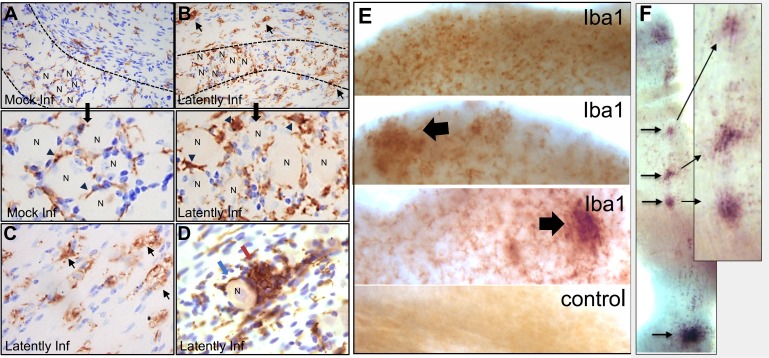
Detection of Iba1+ microglia in HSV infected and mock infected ganglia.Ganglia (A-D) were directly fixed in 4% formaldehyde, embedded, sectioned, and assayed for Iba1 expression as described in Methods. (A and B) Images of representative sections through a mock-infected (A) or latently infected (B) ganglion. Dashed lines indicate the border between the axonal and neuronal regions of the ganglion. Thin elongated cells expressing Iba1 (brown DAB reaction product) are present around neuronal bodies and along the axonal tracts (arrowheads) throughout the mock infected ganglion (A). In the latently infected ganglion, Iba1 expressing cells exhibit distinct morphologies, including large, round cells and vacuolated (foamy) cells along the axonal tracts (B and C) (arrows). “N” indicates a neuronal cell body. Clusters of neurons are marked in both A and B and shown at higher magnification. (D) Nodule of Iba1+ cells (brown) in latently infected ganglia pre-hyperthermic stress (red arrow) juxtaposed to a morphologically intact neuron (blue arrow). (E-F) At 34 h phs, ganglia were fixed in 0.5% formaldehyde and assayed for Iba1 expression in the whole ganglia, as described in Methods. (E) Low power view showing examples of cells expressing Iba1 protein (brown staining) and a control that was processed without primary antibody. Arrows indicate regions of dense clusters of Iba1 expressing cells found to be associated with viral reactivation (see Fig 6). These dense foci were not present in every ganglion and their numbers paralleled the number of reactivating neurons. (F) Clusters of Iba1+ cells (VIP; purple) were observed lining an axonal tract. Arrows point to the localization of Iba1 clusters at higher magnification.